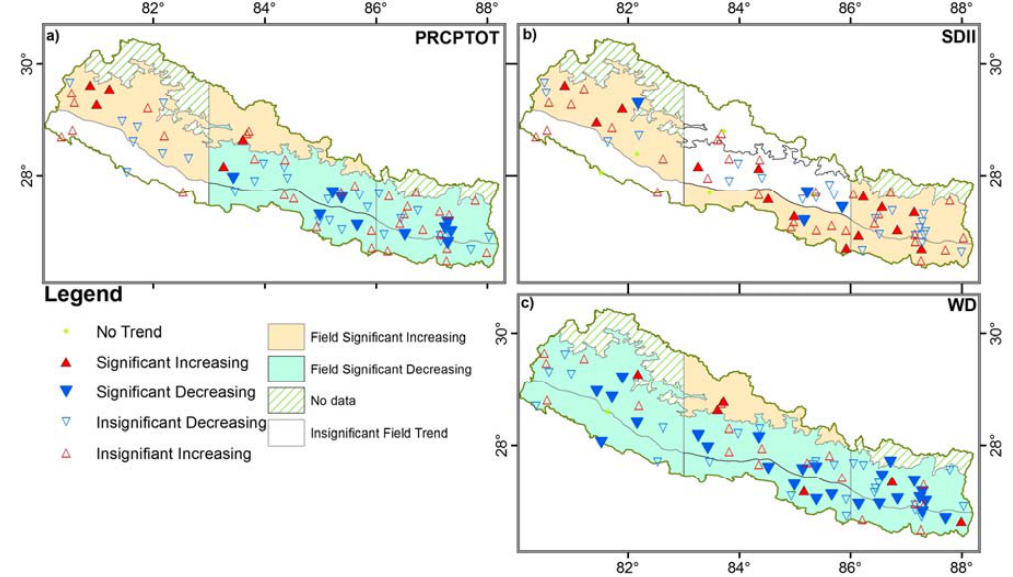
Figure 9. Stationwise and field significant trends for ( a ) PRCPTOT; ( b ) SDII; and ( c ) WD indices (significance at 0.1).